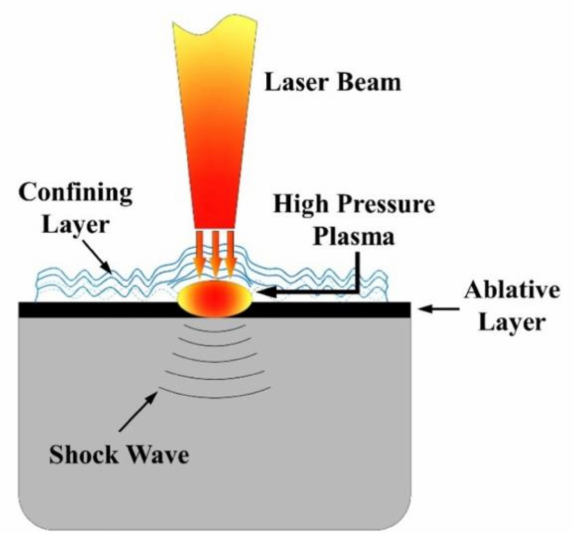
Figure 20. Schematic diagram of laser shock peening process